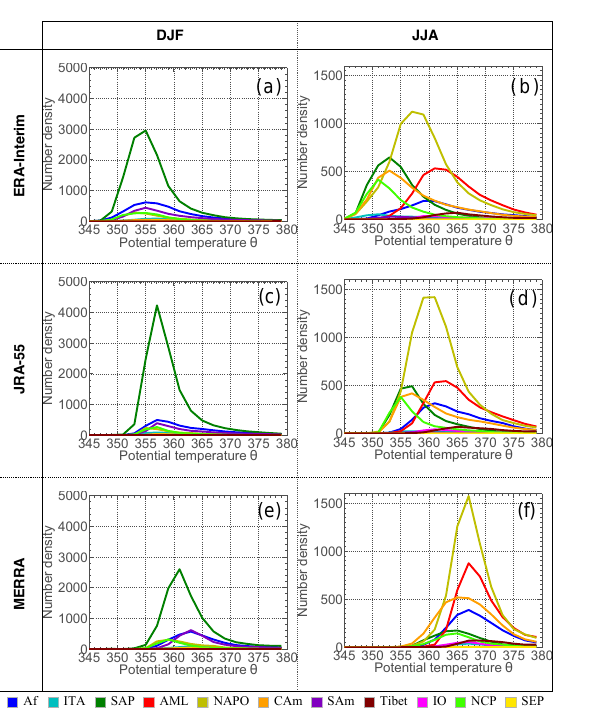
Figure 8. Vertical source distribution for boreal winter (DJF) and boreal summer (JJA) calculated for 2005 with JRA-55 and MERRA reanalyses using the same setup as for ERA-Interim. Upper two panels, for ERA-Interim, are the same as those shown on the two upper panels of Fig.